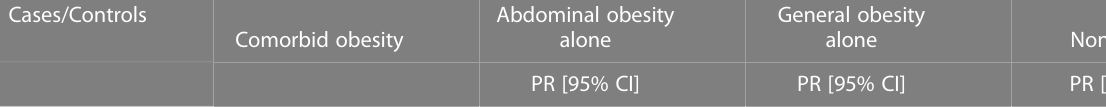
TABLE 2 Associations of obesity subgroups with individual components of metabolic